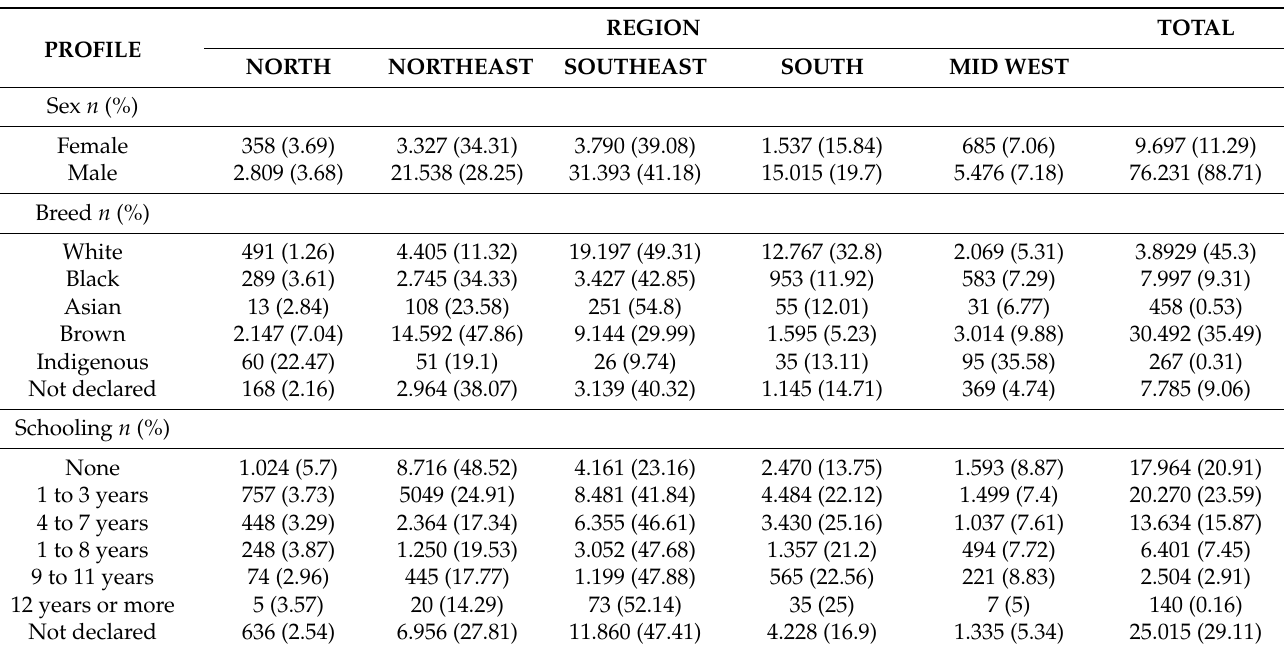
Table 3. Profile of the elderly with a record of death due to alcohol consumption in SIM/DATA SUS between 1996 and 2019 in